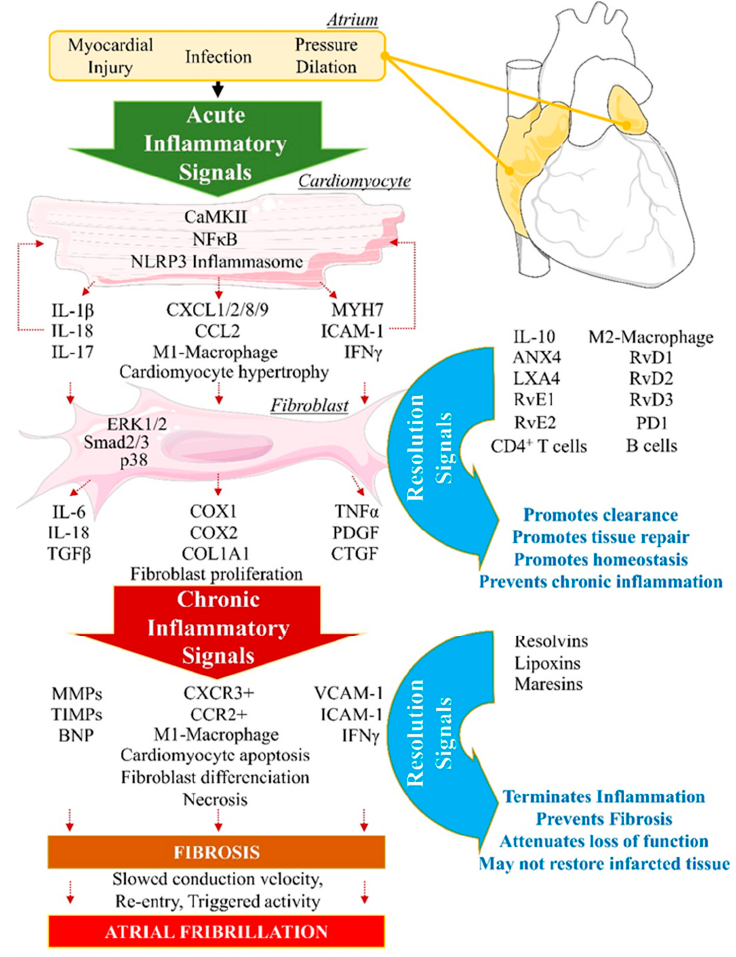
Figure 1. Biomolecular orchestration of cellular events from cardiac insult to resolution opposed to persistent arrhythmogenic inflammation. Longstanding exposure of the atrium to myocardial injuries, infections or chronic pressure and dilation provokes the normal initiation of acute inflam- mation. In cardiomyocytes (CM), intracellular inflammatory response involves CamKII, NF-kB or NLRP3 inflammasome pathways activation, which contribute to CM deregulation of structural genes ( Myh7 ), and secretion of proinflammatory cytokines including interleukins (IL-1 β , IL-18) and chemokines (CXCL, CCL), leading to promotion of proinflammatory (M1)-macrophage infiltration. Proinflammatory signals contribute to the activation of cardiac fibroblasts (FB). FB activate additional pro-inflammatory signals (TGF β , TNF α , PDGF) provoking FB differentiation into myo-FB, aiming to promote repair and wound healing, if the resolution signals are properly activated in response to inflammation initiation. Resolution mediators, including IL-10, LXA4, D- and E-series resolvins, contribute to terminate M1-macrophages infiltration, facilitate anti-inflammatory (M2)-macrophages polarization and phagocytosis, while activating CD4+ T cells and B cells efferocytosis, leading to homeostasis. When Resolution fails to occur, inflammation is perpetuated via FB and myoFB se- cretion of chronic-inflammation-promoting mediators (MMPs, IFN γ , CXCR3+, M1-macrophages) leading to CM necrosis, and loss of function. Resolution signals can be promoted to limit chronic inflammation-induced damages. If failed resolution mechanisms persist, the myocardium is exposed to the development of fibrosis, slowed conduction velocity, triggered activity, re-entry and increased susceptibility to arrhythmias, including atrial